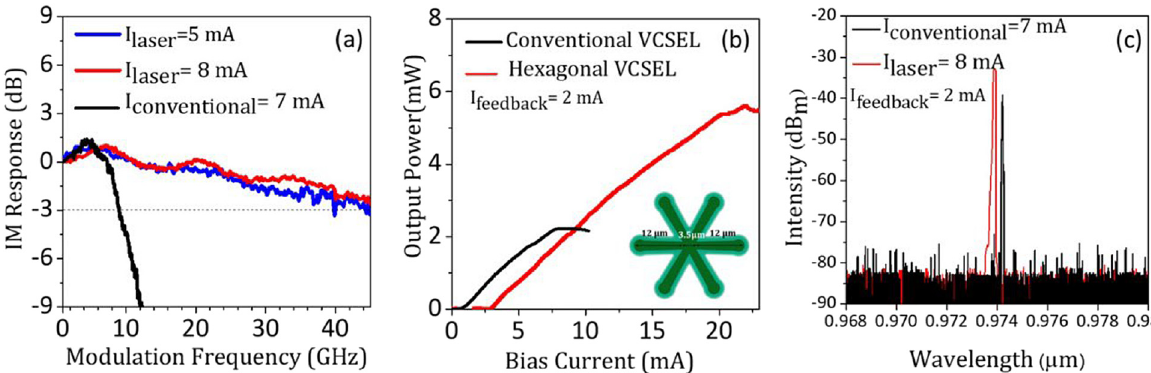
Figure4: (a)Intensitymodulation(IM)responseforvertical-cavitysurface-emittinglasers(VCSEL)withsixidenticalfeedbackcavitieswiththe length of L C = 12 µm and effective aperture size of 3.5 × 25 µm 2 . The IM response with a robust feedback system in the hexagonal VCSEL provides a 3-dB roll-off over 45 GHz based on Equations (1) and (2). We project the coupling strength to be η = 0.12. Conventional VCSEL fabricated on the same epi-wafer with 3-dB roll-off ∼ 9 GHz is shown for comparison, (b) shows out-put power for both conventional (black curve)andour hexagonalone (red curve)versusbias current. Asseenhere,our hexagonalVCSELcan bedrivenwith largeof currents(>20mA) and output power still linearly increases to ∼ 5.5 mW, which is triple of its conventional VCSEL, and (c) a single-mode operation for our hexagonal VCSEL with SMSR of >30 dB and SNR of >45 dB is